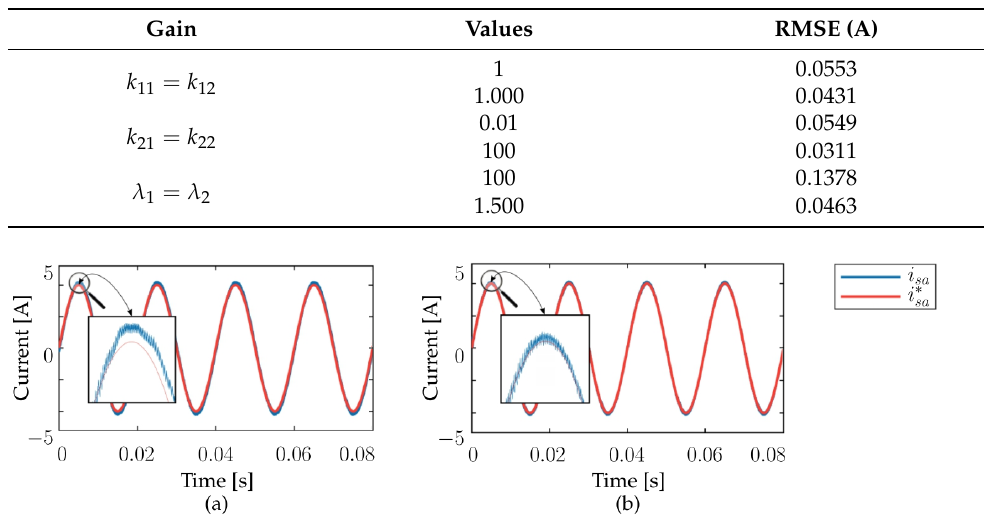
Table 2. RMSE in gain adjustment.